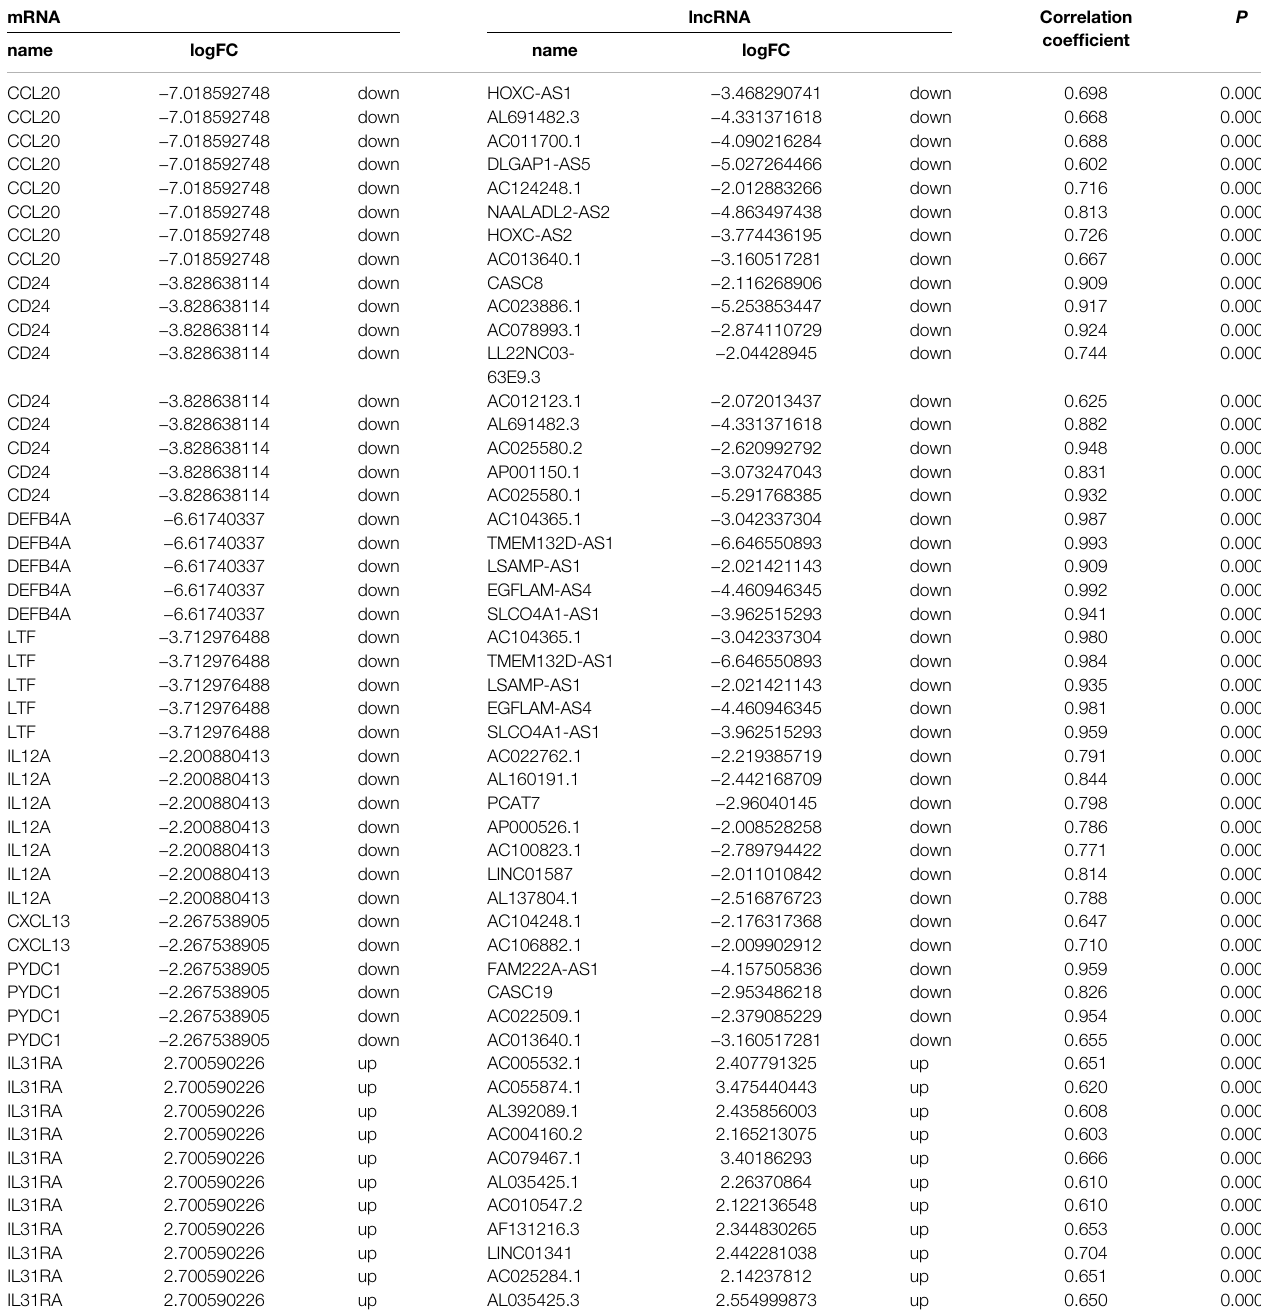
TABLE 2 | Differentially expressed immune-related gene